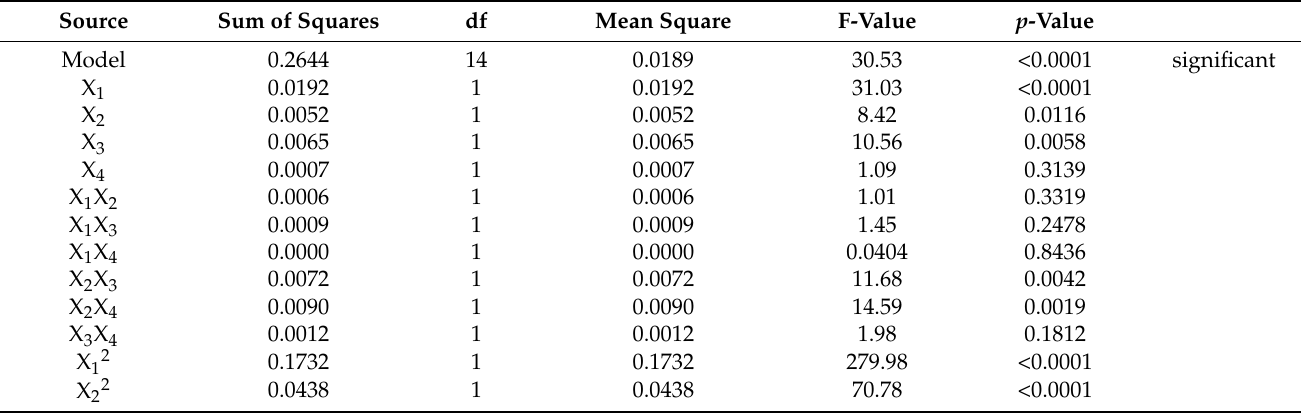
Table 2. The results of ANOVA for Response Surface Reduced Quadratic